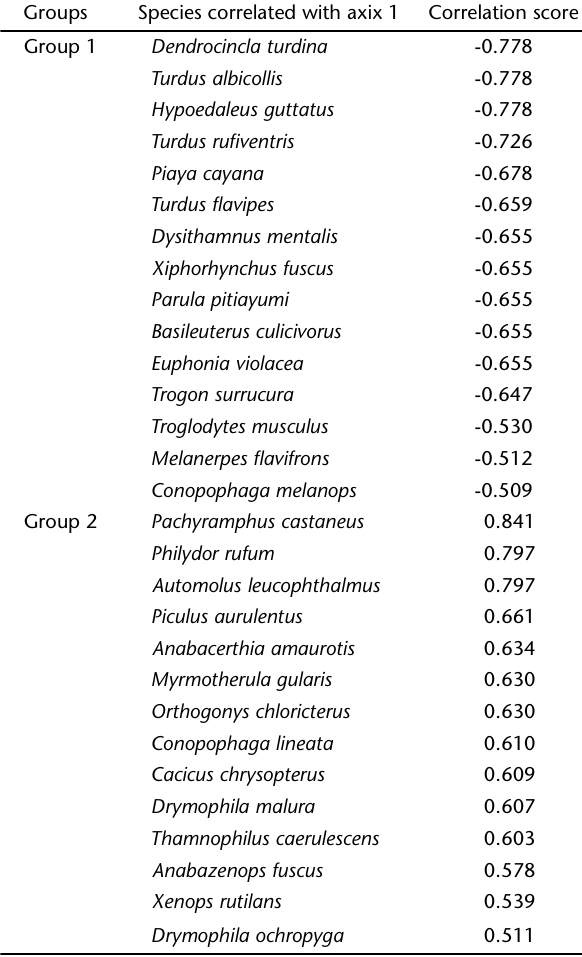
Tabela V. Correlation scores between the bird species participating in mixed flocks and axis 1 of the Correspondence Analysis diagram. Only species with correlation values in relation to axis 1 (cid:2) 0.5 are